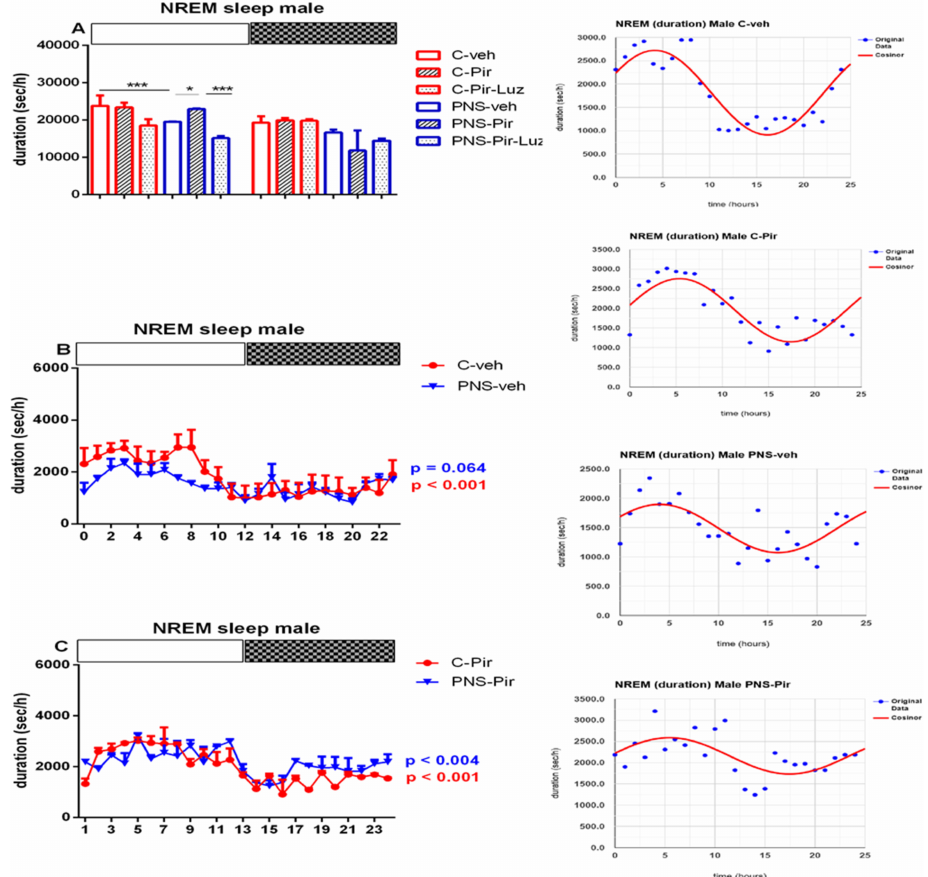
Figure 7. Diurnal rhythm of NREM duration (sec/h) in male rats during the Light and the Dark phase, indicated by open and black rectangles above the figure, over a 24-h recording for C-veh, C-Pir, C-Pir-Luz, PNS-veh, PNS-Pir and PNS-Pir-Luz group ( A ). Circadian distribution of NREM sleep events (duration, sec/h) for C-veh and PNS-veh groups ( B ) and C-Pir and PNS-Pir groups ( C ) over a 24-h recording. Original and cosinor data are shown in inset on the right. * p < 0.05, *** p < 0.001 vs. C-veh, PNS-veh or PNs-Pir group,